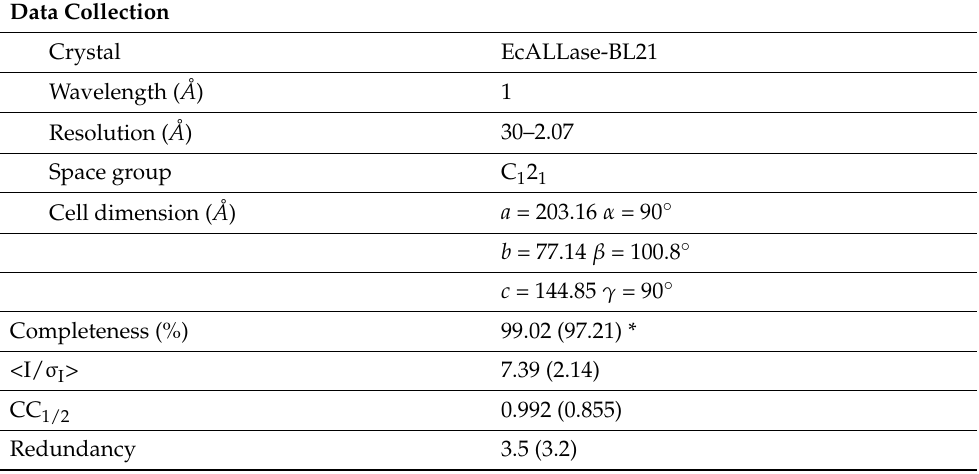
Table 1. Data collection and refinement